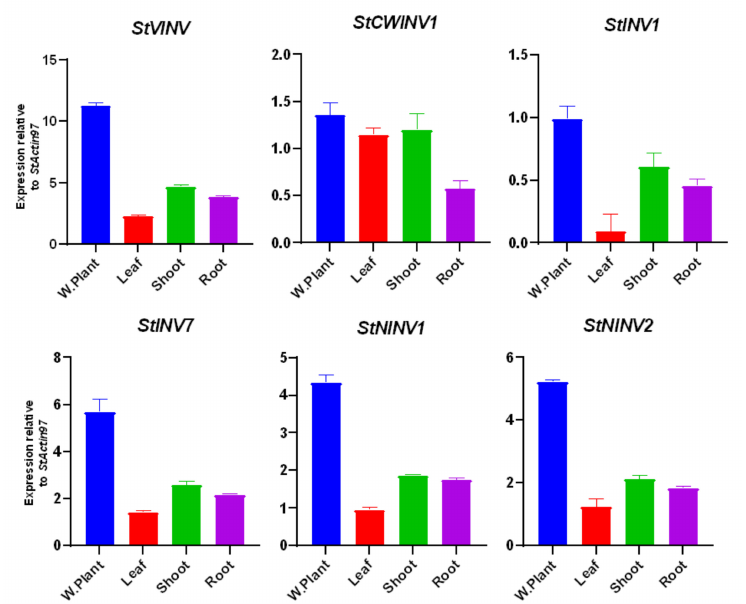
Figure 11. Expression pattern of invertase genes under drought stress. Fold change values are plotted, StActin97 is used as an internal control for three biological replicates of each sample in the experiment. Bars are drawn for